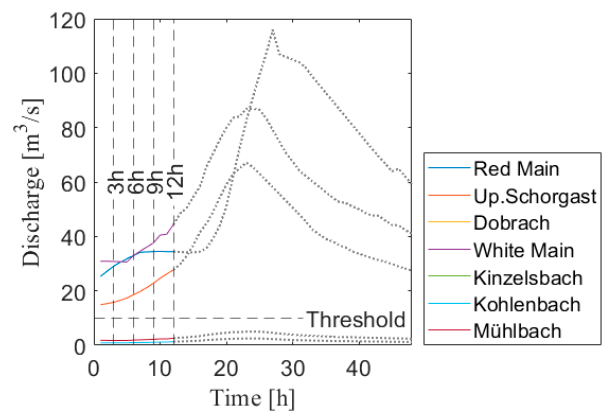
Figure 9. Hydrographs of the flood event in 2005. Seven discharge curves of three rivers and four streams are shown in different colors. Time 0 marks the start of the prediction. The dash lines upon the discharge curves mark the different discharge sections for prediction inputs.